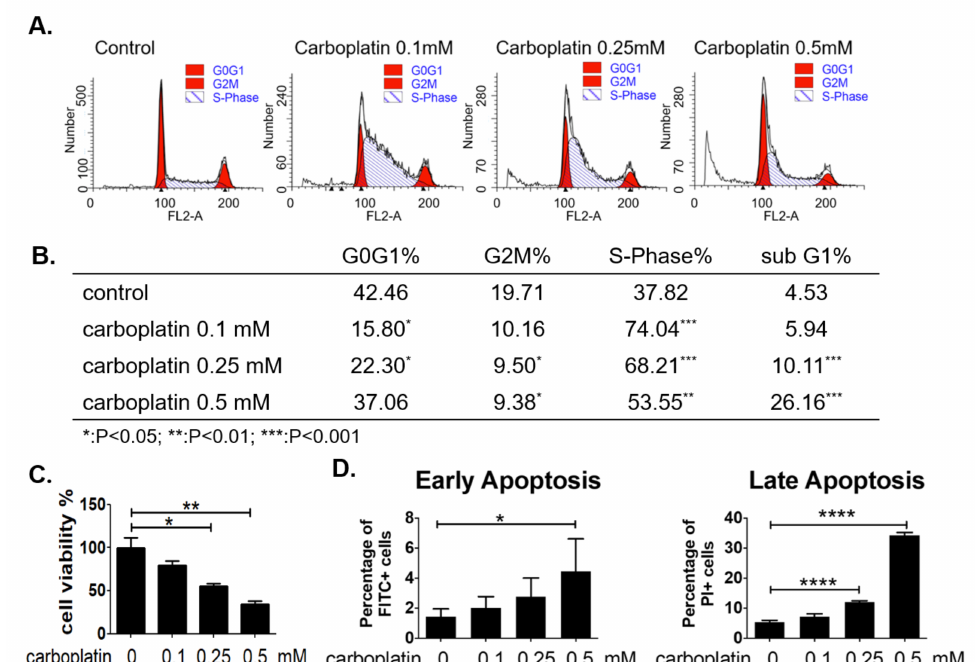
Figure 3. Carboplatin induced S-phase arrest and apoptosis of megakaryocytic cells dose-dependently in vitro. ( A , B ) MEG-01 cells were treated with different dose of carboplatin for 24 h and cell cycle distribution was analyzed by flow cytometry. ( C ) Cell viability of MEG-01 cells was determined at 24 h after carboplatin treatment by trypan blue exclusion assay. ( D ) Percentage of the early and late apoptotic cells was analyzed based on the results of flow cytometry. (* p -value < 0.05, ** p -value < 0.01, **** p -value < 0.0001, three independent experiments were